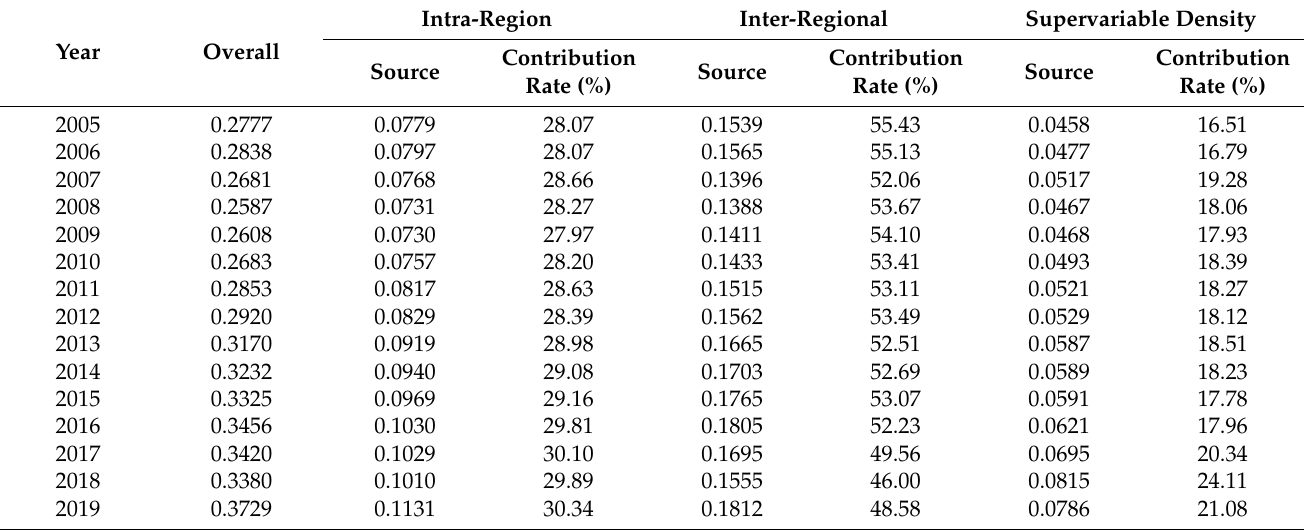
Table 4. Gini coefficient of carbon emission intensity from urban production energy consumption.